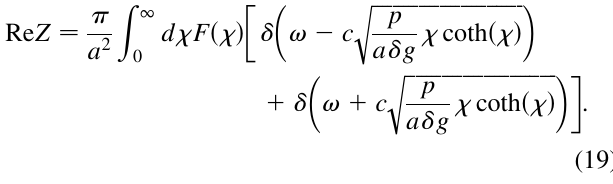
FIG. 2. (Color) The function F (cid:3) * (cid:5) (solid line) and the approxi- mation 4 *e (cid:4) 2 * , valid for * * 1 (dashed line).